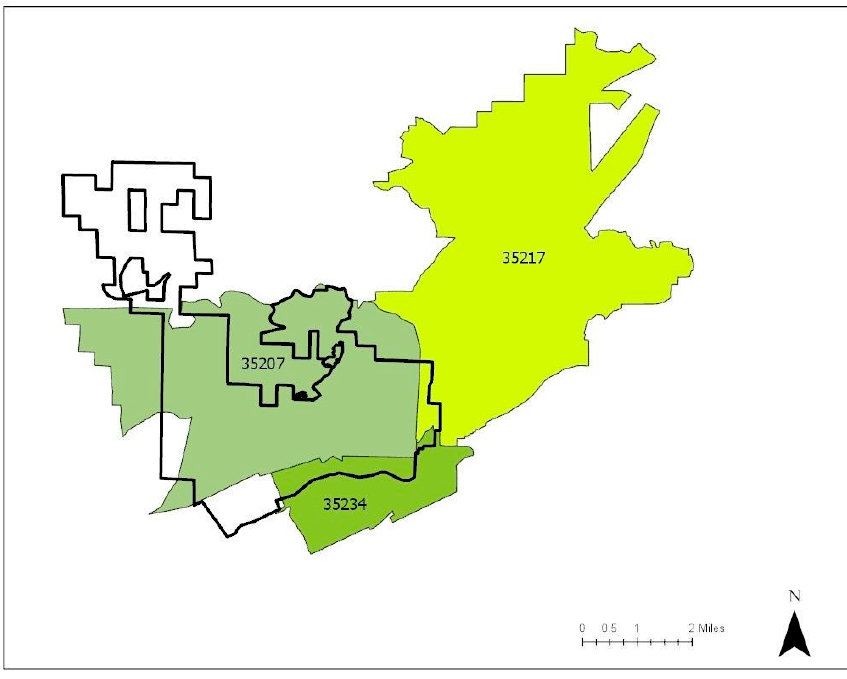
Figure 2. Zip codes impacted by heavy industry and the 35th Avenue Superfund Site.